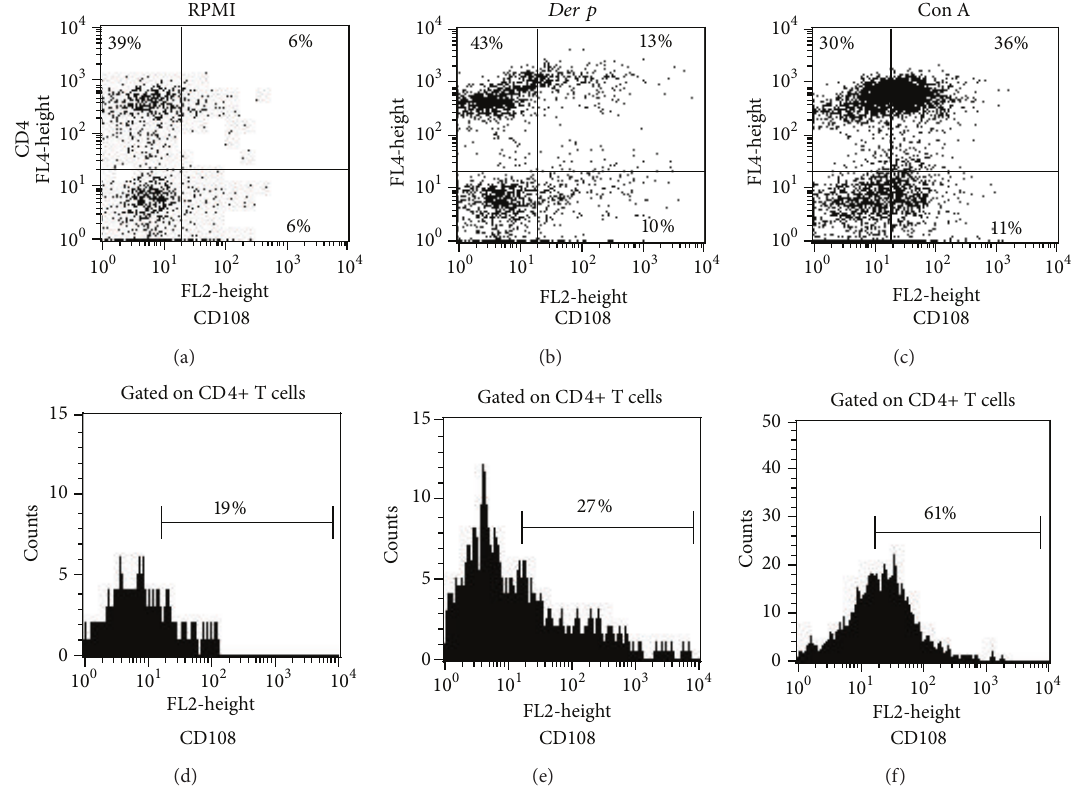
Figure 5: Increased frequency of CD108+ cells after allergen-stimulation. Representative dot plots of (a) nonstimulated cells, (b) Der p - stimulated cells, and (c) Con A-stimulated cells. Representative histograms of CD4+ gated cells, (d) nonstimulated cells, (e) Der p -stimulated cells, and (f) Con A-stimulated cells; 𝑥 -axis denotes fluorescence to CD108 on CD4+ gated